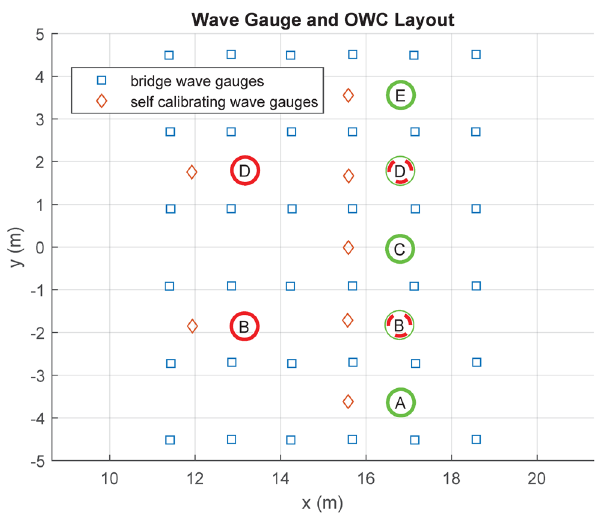
Fig. 6. Wave gauge OWC locations for tests. Bridge wave gauges are shown in blue squares corresponding to three bridge positions. Self-calibrating wave gauges were fixed for all tests. Green circles represent OWC locations for optimal layout. Red circles represent movement of OWC B and D for non-optimal